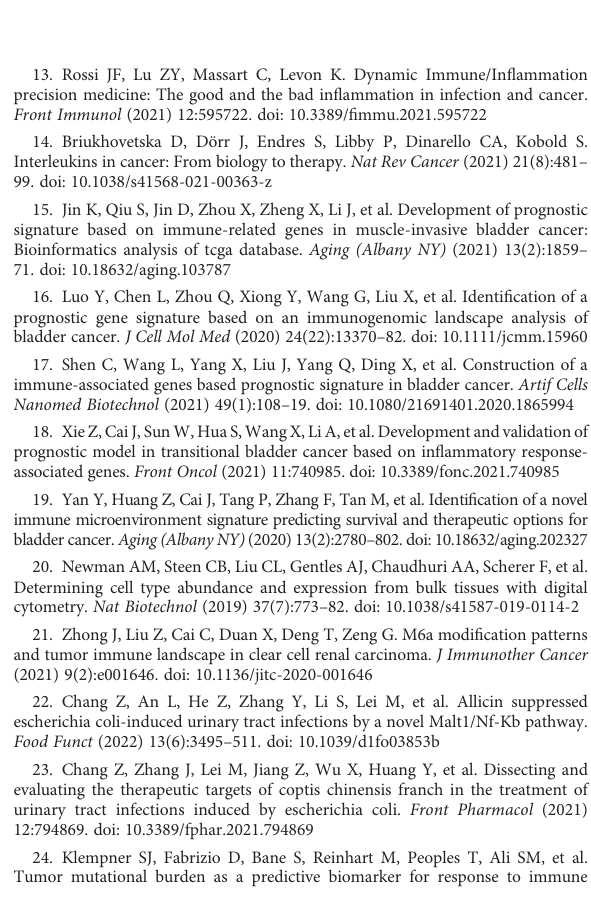
Evaluation of the performance of IIRS in different clinical subgroups of TCGA-BLCA patients. (A-E) The KM curves of IIRS in BLCA patients with different ages, gender, stage, T, and